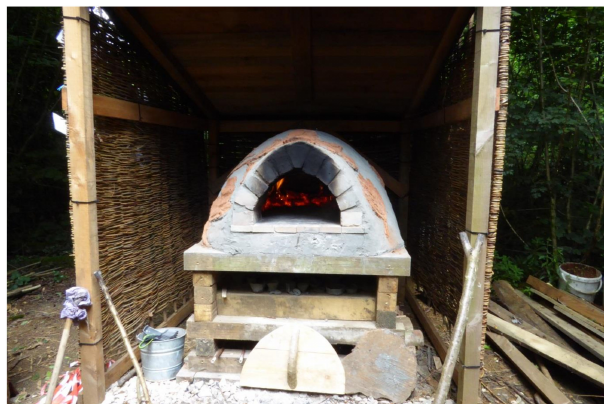
Figure 3. The cob oven in the community shelter area at Westonbirt